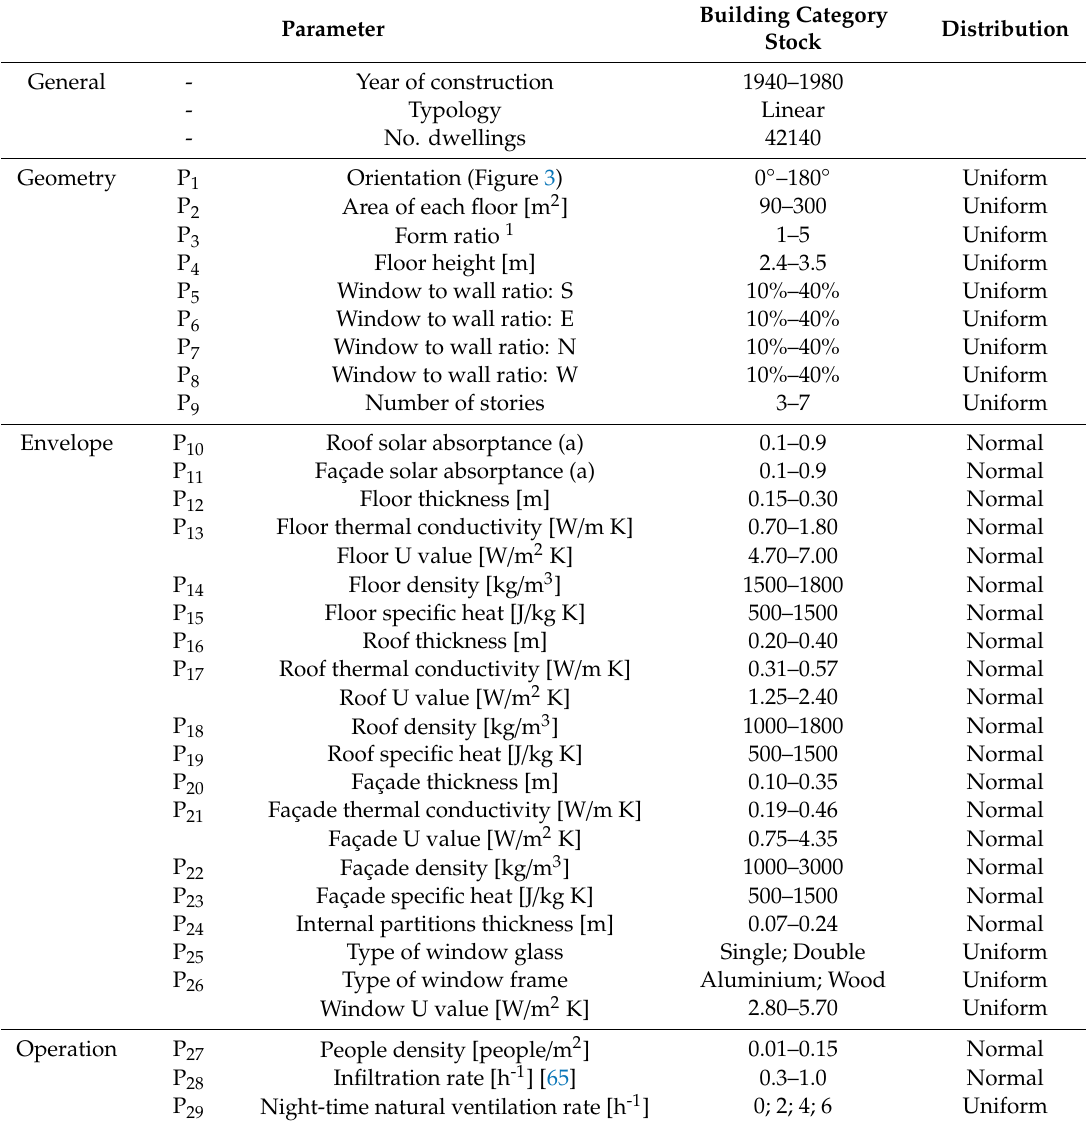
Table 2. Characterization of the parameters of building category case study.